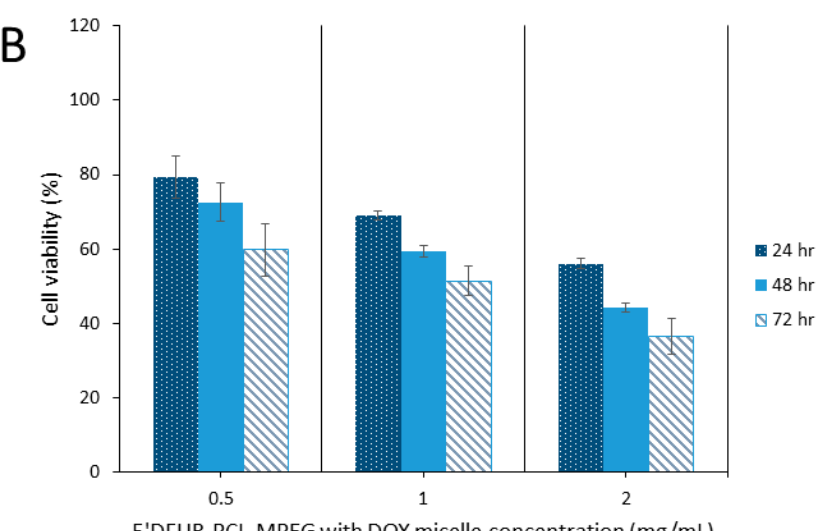
Figure 9. Cell viability of HT-29 cells after treatment with polymeric micelles encapsulating DOX for 24, 48, and 72 h. ( A ) MPEG 350 -PCL-MPEG polymeric micelles, ( B ) 5’-DFUR-PCL-MPEG polymeric micelles (mean ± SD, n = 3).